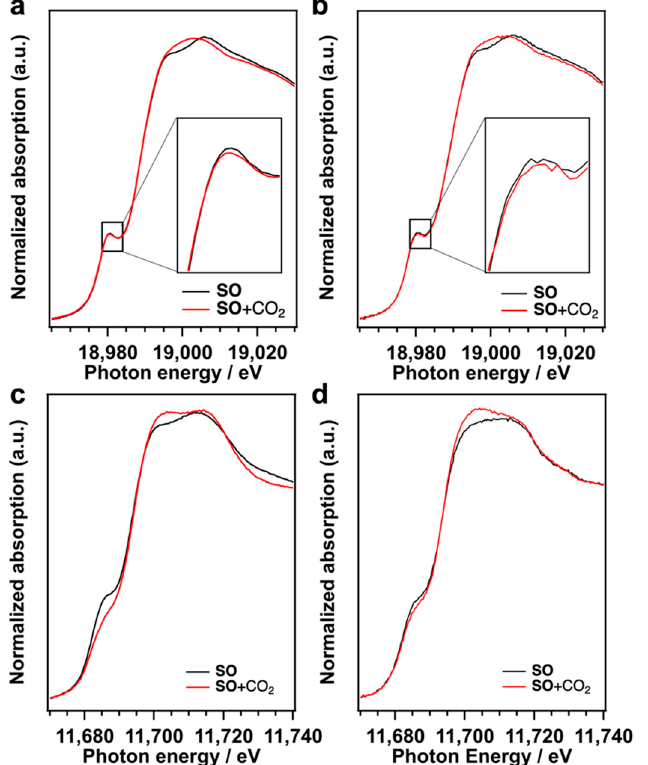
Figure 5. ( a ) Nb K-edge of TBA-Nb 6 and ( b ) TBA-Ta 1 Nb 5 , and ( c ) Ta L 1 -edge XANES spectra of TBA-Ta 6 and ( d ) TBA-Ta 1 Nb 5 in SO solution before (black line) and after (red line) introduction of CO 2 .